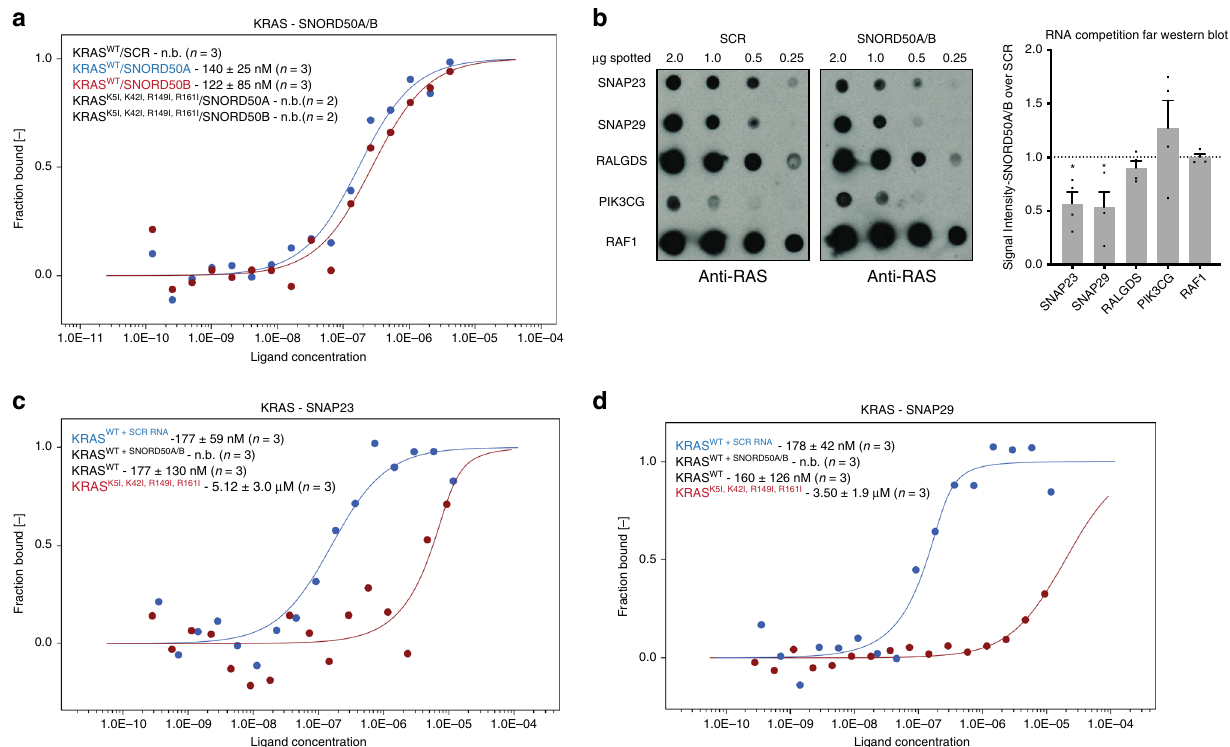
Fig. 3 SNORD50A/B and SNAREs compete for KRAS binding. a Dissociation curves of recombinant puri fi ed wild-type KRAS protein and the RNA-binding- de fi cient KRAS K5,K42R149,R161 mutant vs. SNORD50A and SNORD50B snoRNAs measured by MST (n.b. = no binding detected). b RNA competition far western of KRAS interaction with SNAREs and canonical effector proteins; SCR = length and sequence nucleotide composition matched scrambled RNA control for SNORD50A/B ( n = 3, representative images shown). Signi fi cance of SNAP23 and SNAP29 decrease in KRAS association calculated in comparison to Raf1. Dissociation curves of KRAS vs. SNAP23 c and SNAP29 d by MST in the presence of the RNAs noted. K d values calculated from 3 independent experiments. Error bars are